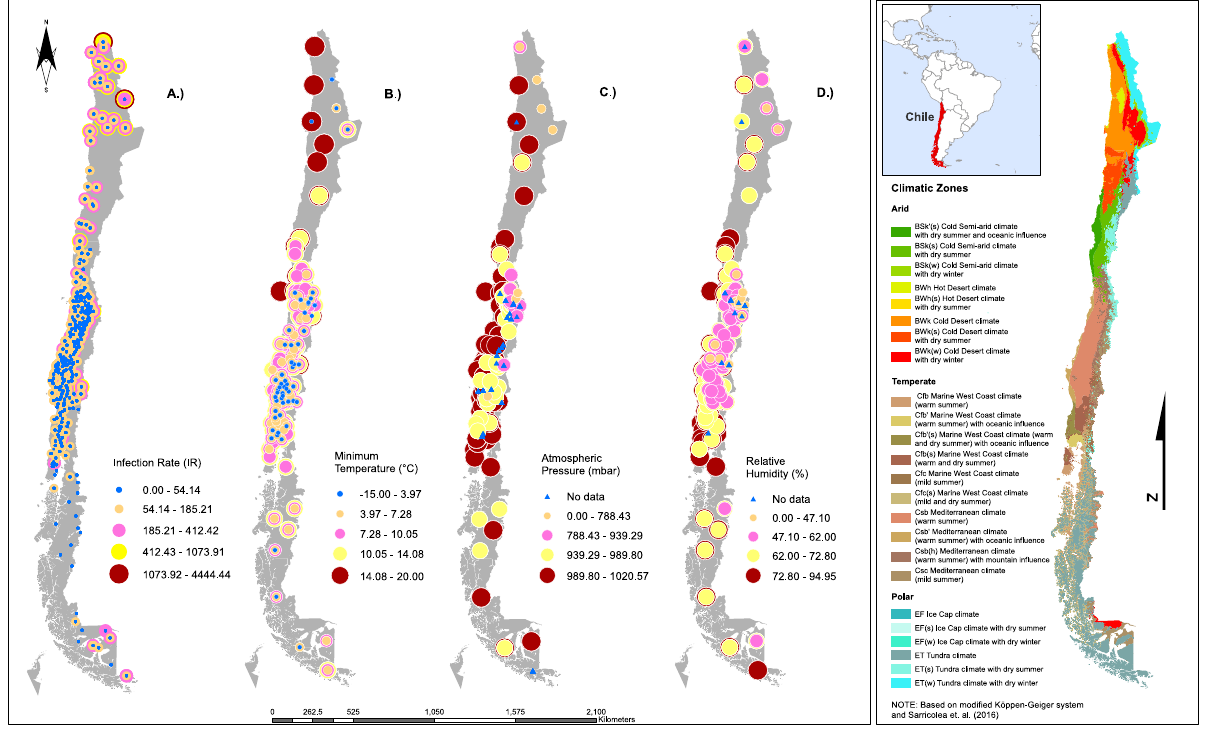
Figure 4. Map of Chilean distribution of ( A ) infection rate, ( B ) minimum temperature (°C), ( C ) atmospheric pressure (kPa), and ( D ) relative humidity